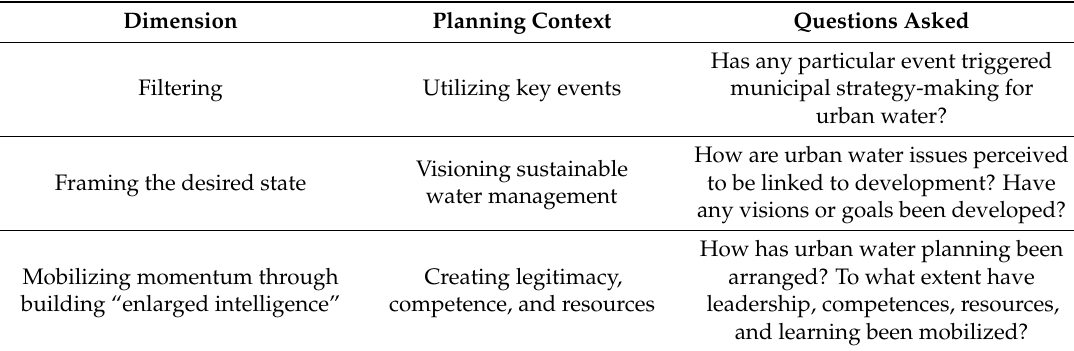
Table 1. Dimensions used to analyze strategy-making for sustainable urban water management.